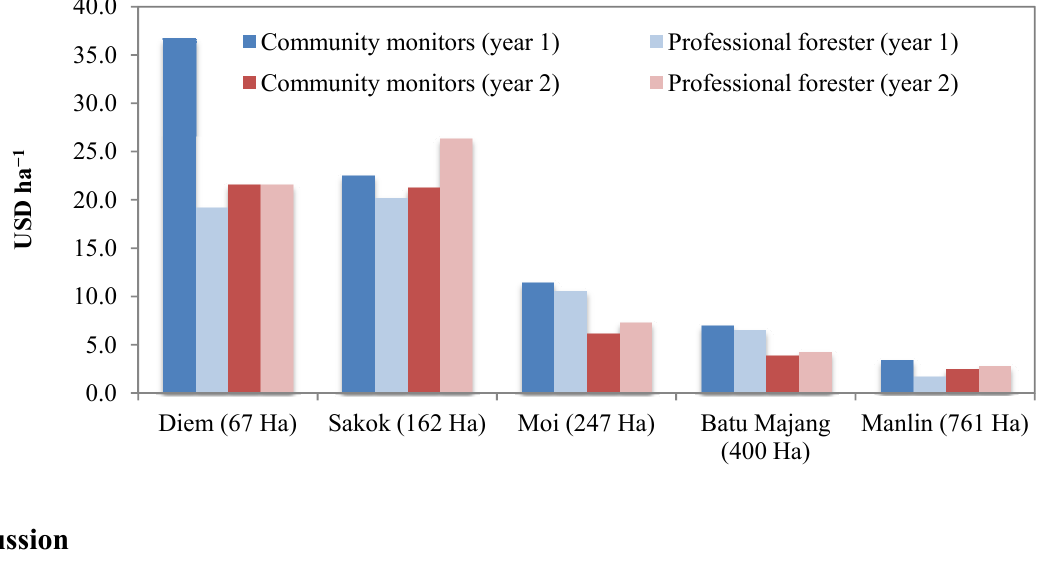
Figure 4. Cost USD ha − 1 for community monitors and trained foresters in the monitoring year 1 and